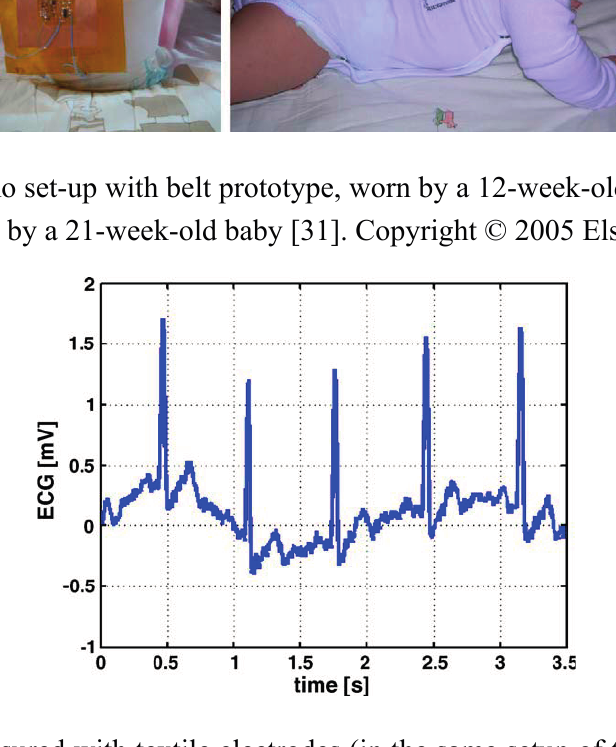
Figure 4. ECG measured with textile electrodes (in the same setup of the belt prototype in Figure 3) [31]. Copyright © 2005 Elsevier